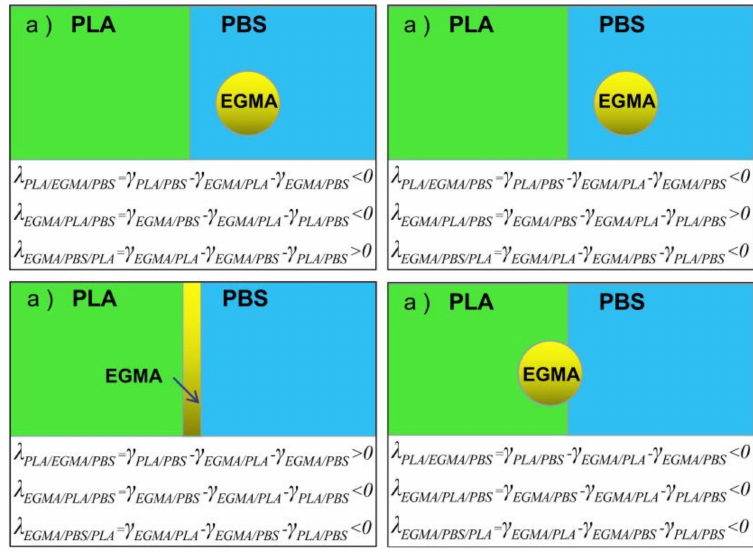
Figure 7. Possible morphologies predicted by spreading coefficients.